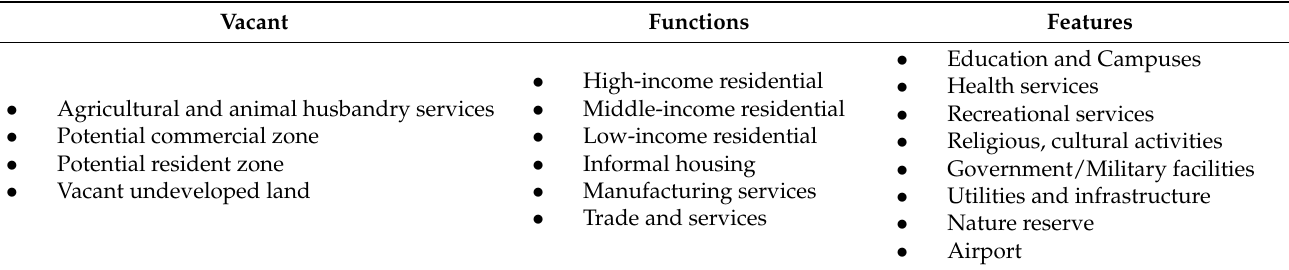
Table 1. Land use classes modelled in the Cape Town Model. Vacant